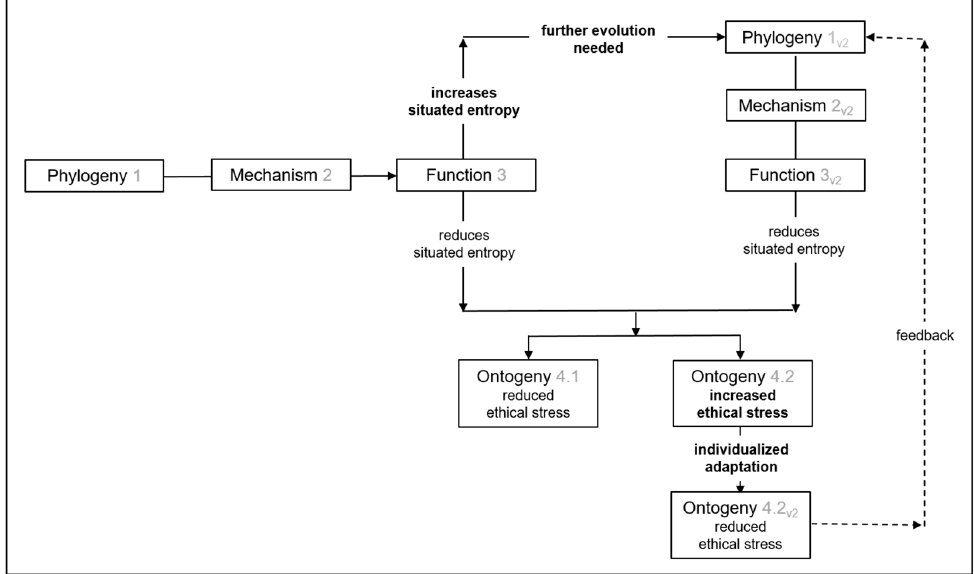
Figure 1. Behavioral ecology analysis of human-AI systems. Iterations of system evolution (phylogeny) and individual adaptations (ontogeny) of system mechanism are needed in order to minimize situated entropy from system function that can cause ethical stress.